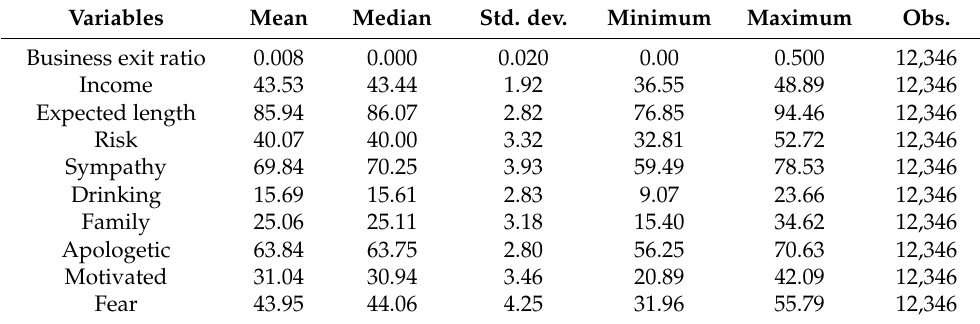
Table 2. Basic statistics of the